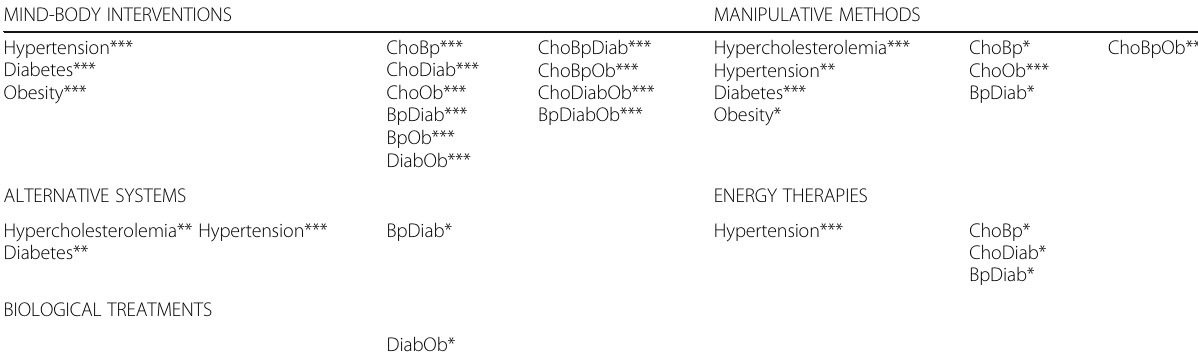
Table 5 Statistically Significant CAM Modality Use by Disease Status MIND-BODY